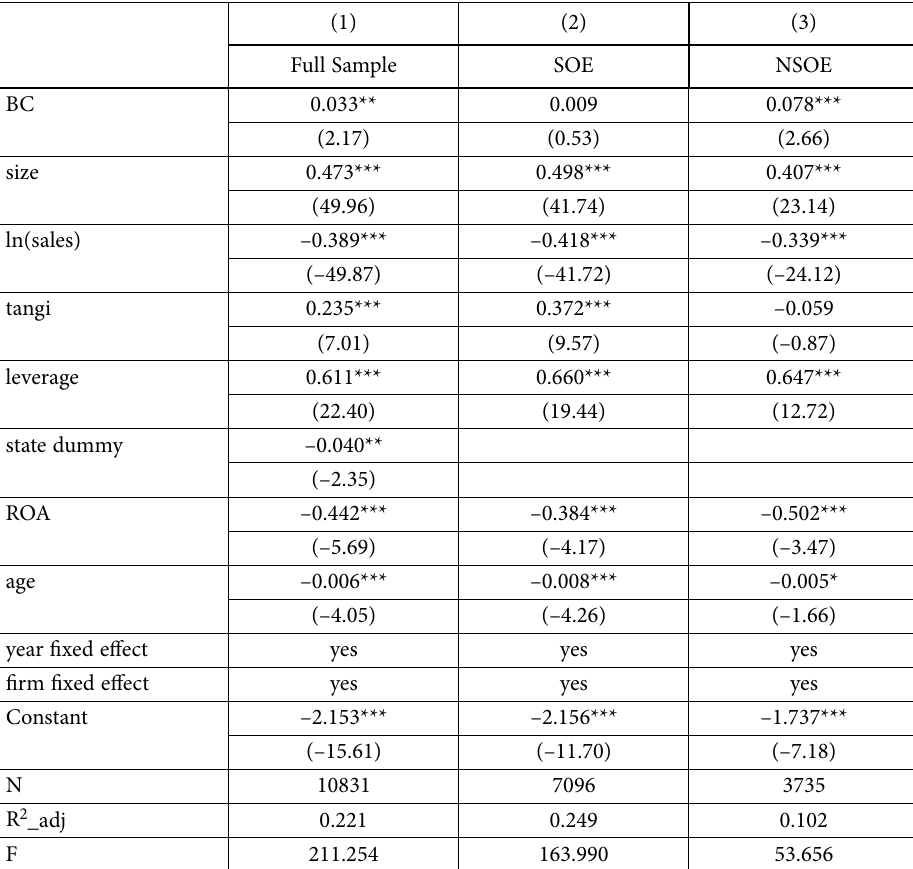
Table 3. Relationship between bank connections and long-term